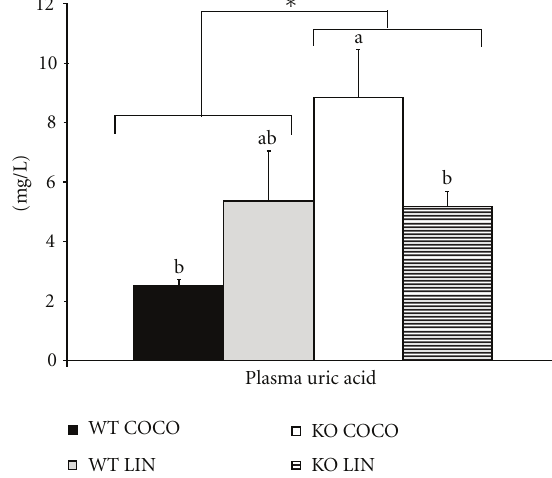
Figure 2: Plasma concentrations of uric acid in WT and PPAR α - deficient (KO) mice fed diets containing either saturated FA (COCO diet) or ALA (LIN diet) for 8 weeks. Values are means ± standard errors for 7 mice per group, ∗ KO group significantly di ff erent from WT group P < 0.05. Columns sharing a same superscript letter, or without superscript letter, were not significantly di ff erent at P <